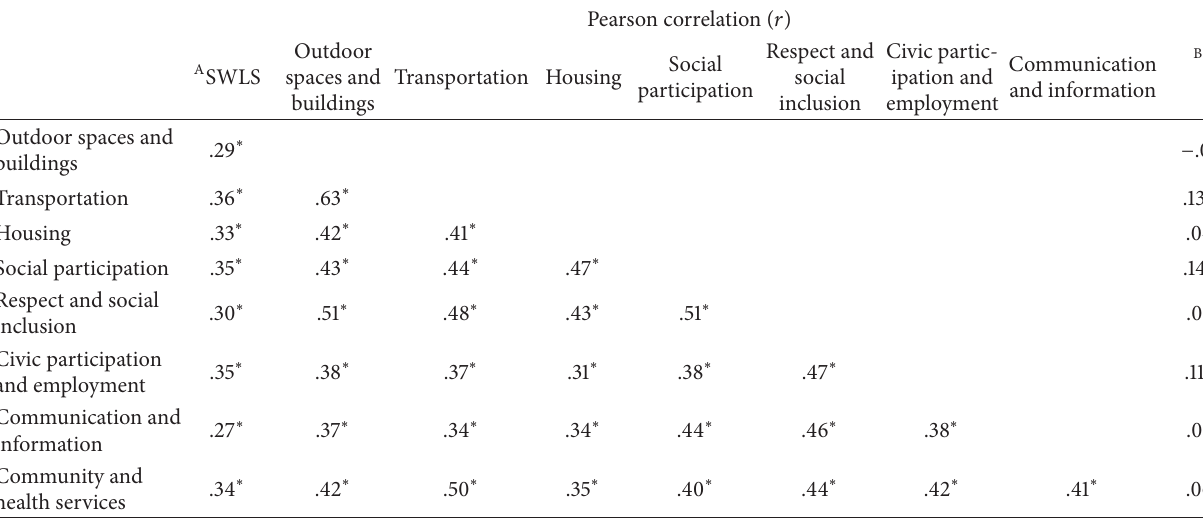
Table 6: Correlations and results from regression analyses of AFC score in association with SWLS score in old-old participants.